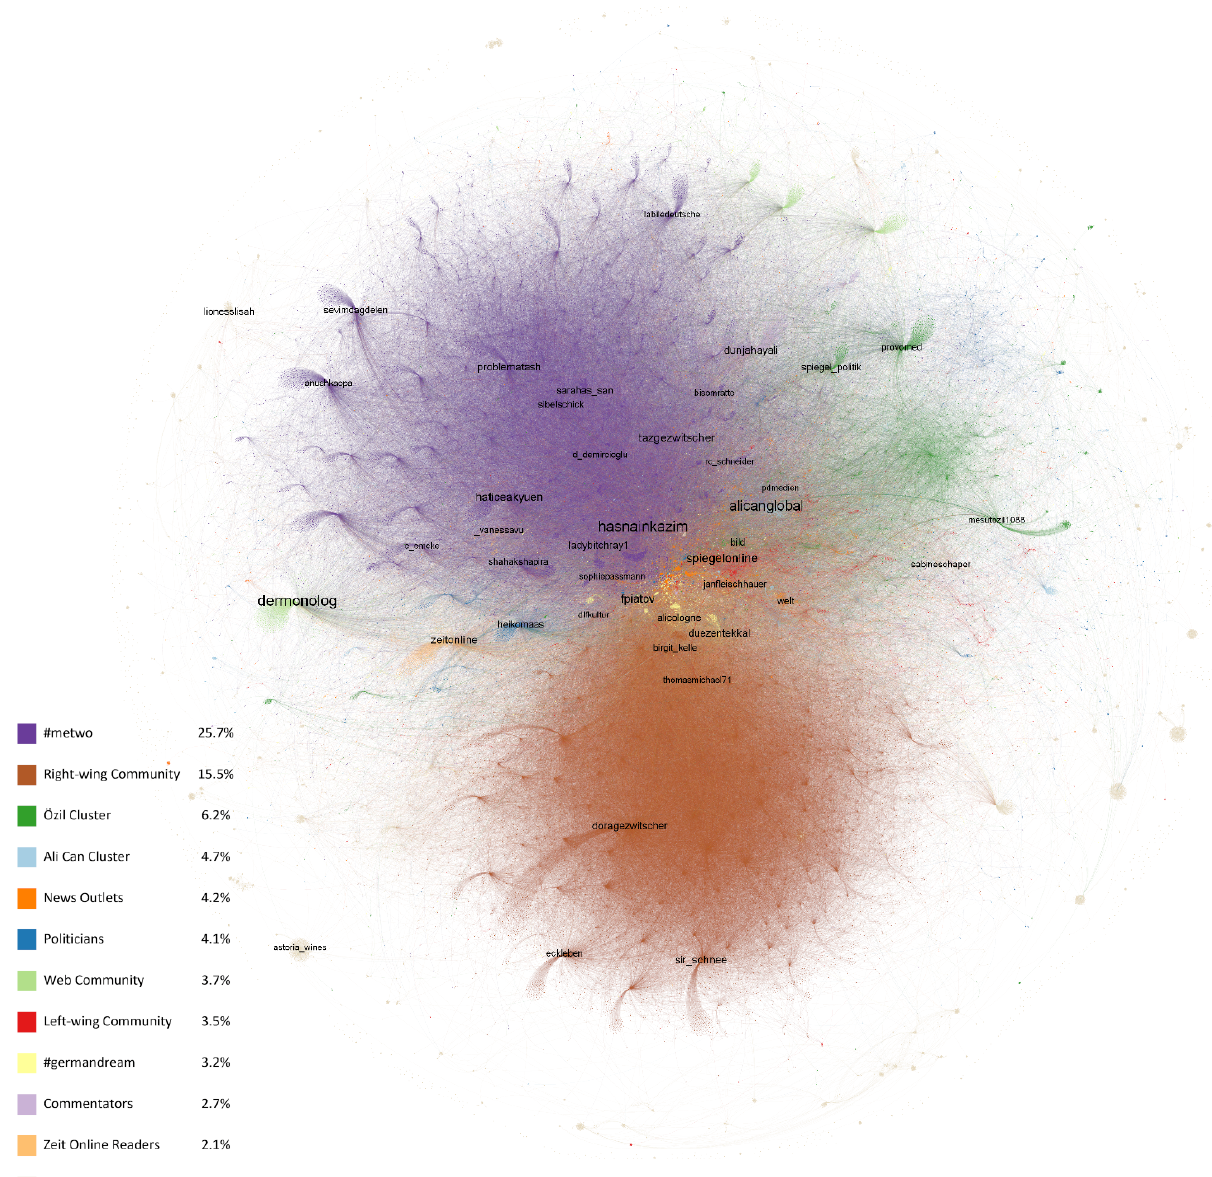
Figure 2. Network graph of communities. Node and label sizes according to PageRank. Share of communities annotated in legend. Graph layout with ForceAtlas2 (Jacomy, Venturini, Heymann, & Bastian, 2014) in Gephi (Bastian, Heymann, & Jacomy,